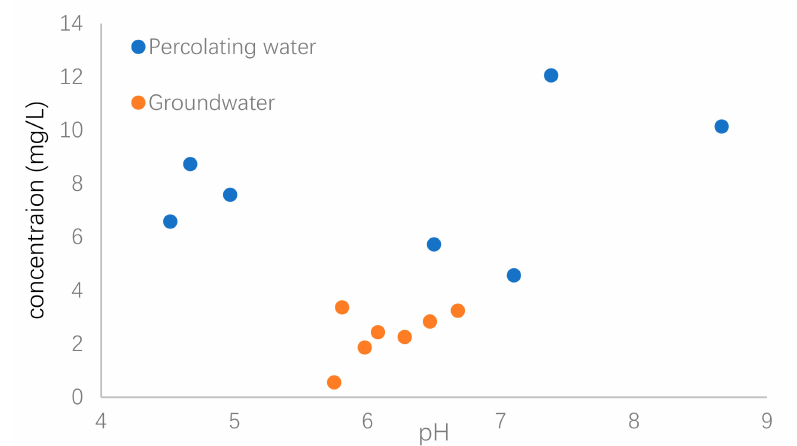
Figure 5. Variation of pH and U concentrations in percolating water and